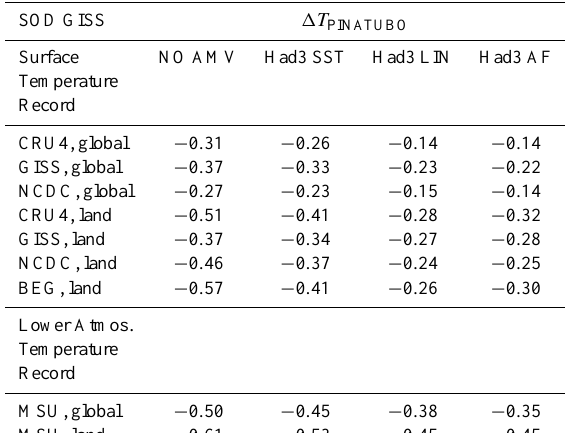
Table 1. Maximum cooling due to Mt. Pinatubo for all model sim-